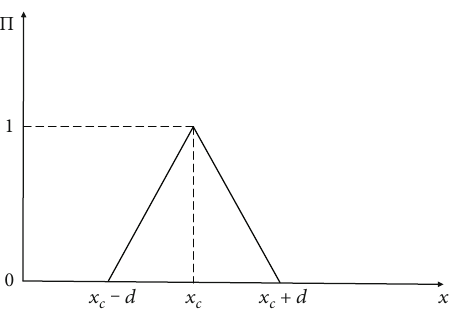
Figure 2: The graph of membership function Π